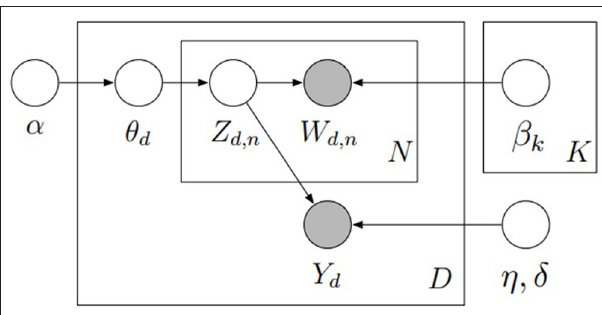
FIGURE 2 | Graphical representation of the supervised latent Dirichlet allocation (sLDA). Source: Blei and McAuliffe (2009).